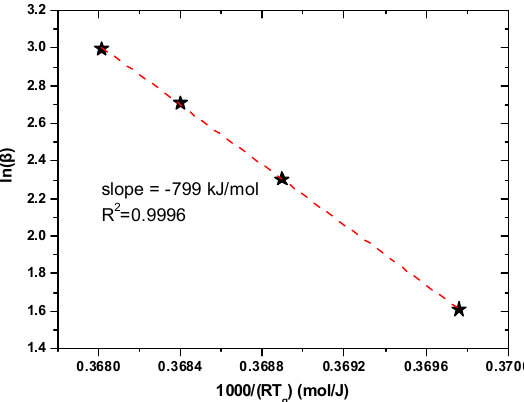
Figure 10. Estimation of the average activation energy at the glass transition for PMePF.